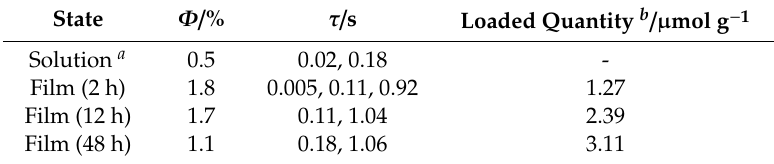
Table 1. Photophysical data of 1 in solution and Nafion film.